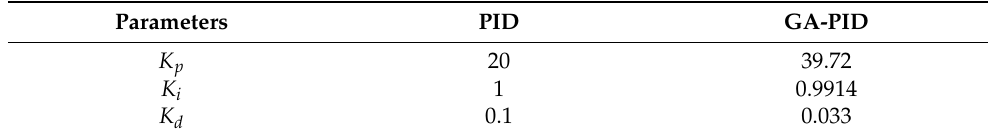
Table 2. Parameter values of ordinary PID and GA-optimized